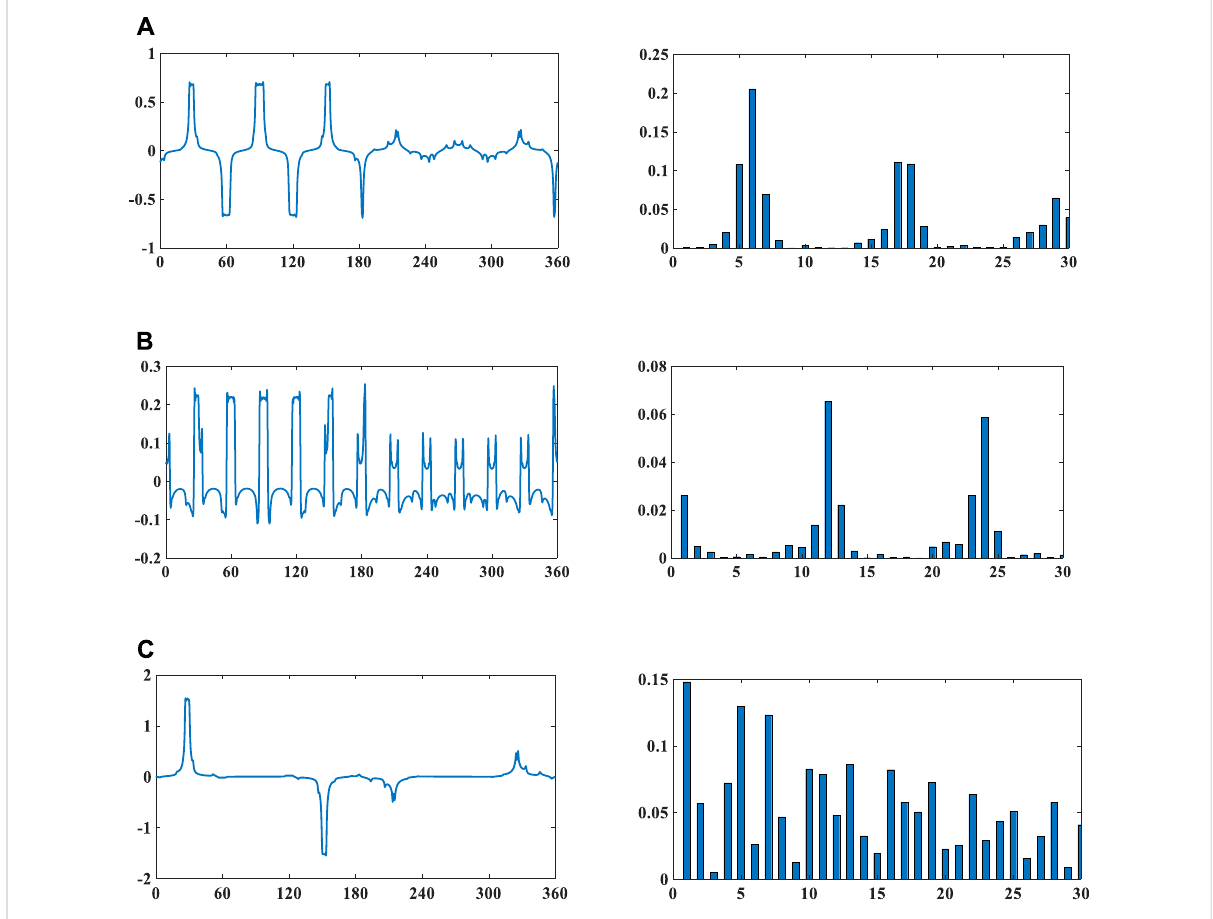
FIGURE 9 Flux density in the air gap and its harmonic distribution. (A) Only DC 5A. (B) Only outer-layer ferrite PMs. (C) Only AC armature current